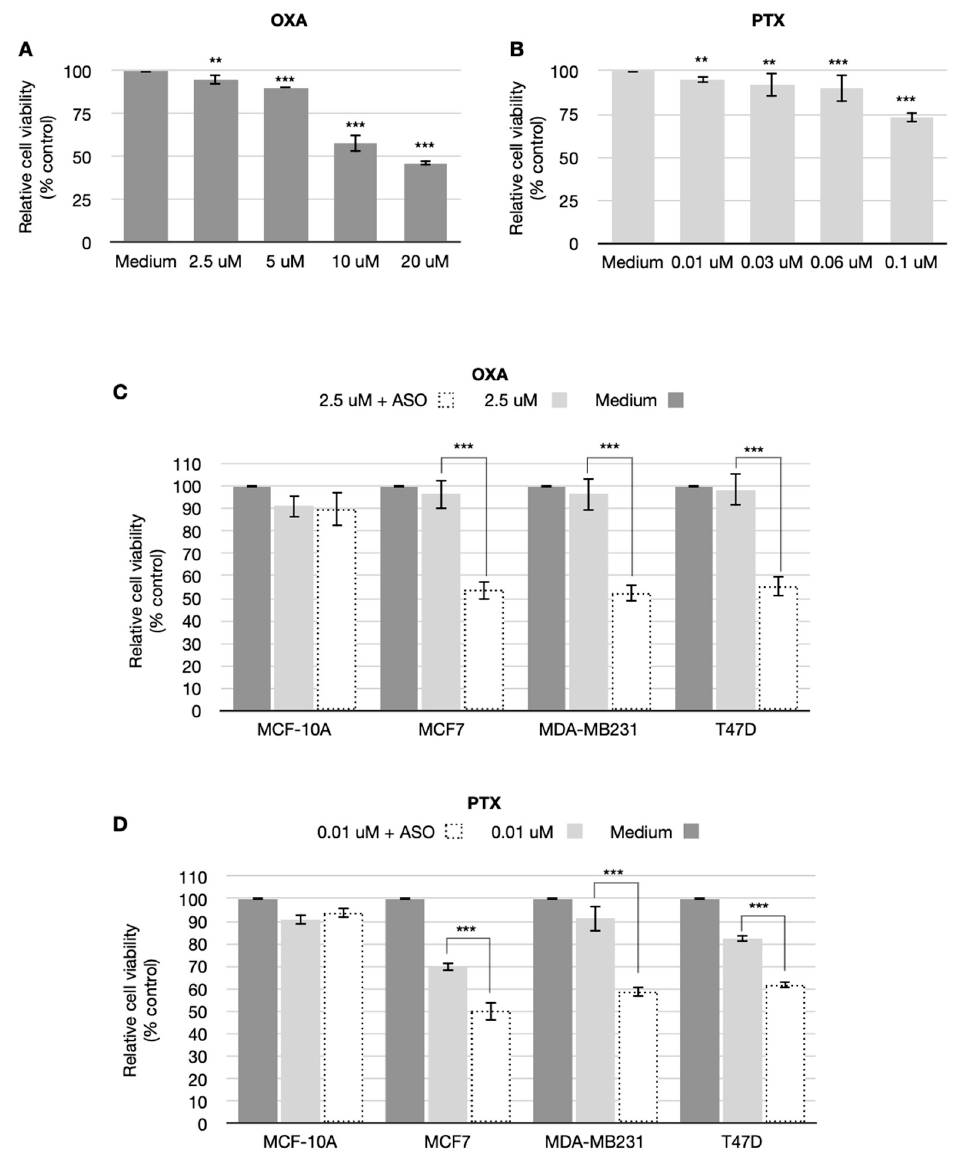
Figure 4. ( A , B ) Graph showing relative cell viability obtained by MTT assay in MCF-10A cell line after 24 h of either OXA or PTX treatment. Data are presented as means ± SD of three independent experiments. ** is for p < 0.01, *** is for p < 0.001 calculated with χ 2 test. ( C , D ) Graph showing relative cell viability obtained by MTT assay in MCF-10A and MCF-7, MDA-MB231, and T-47D cell lines after 24 h of either OXA or PTX alone and combined CSA ASO plus OXA or PTX treatments. Data are presented as means ± SD of three independent experiments. *** is for p < 0.001 calculated with ANOVA tests.